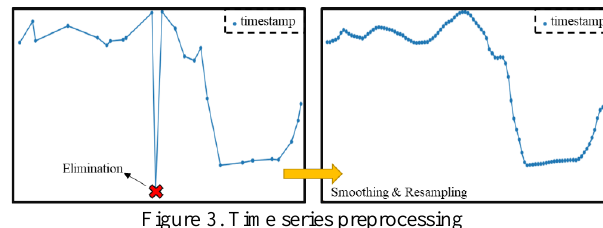
Figure 3. Time series